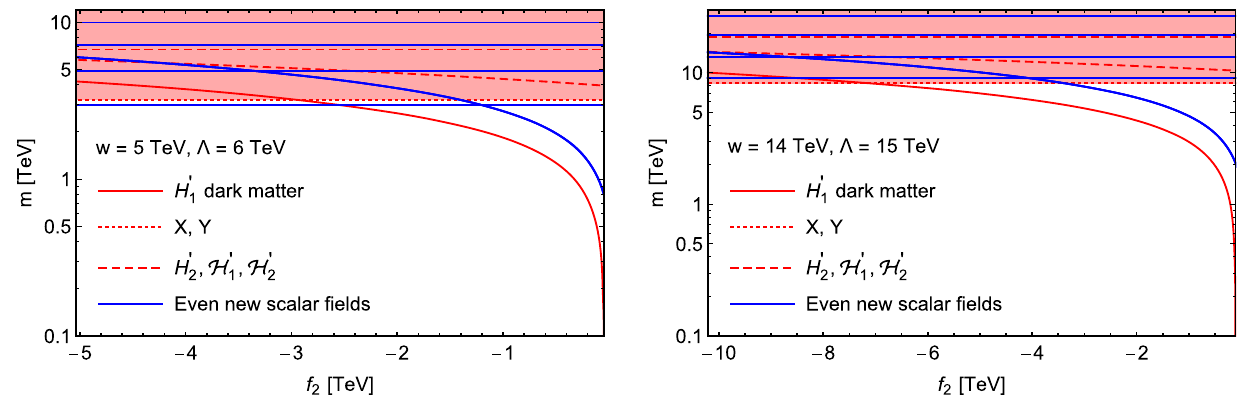
Fig. 3 The masses of the new scalar fields and the odd gauge bosons as functions of the parameter f 2 according to the several choices of w,(cid:11) , where the dark field lines are put as red and the DM stable regime (i.e., below the light red background) is bounded by the X , Y line